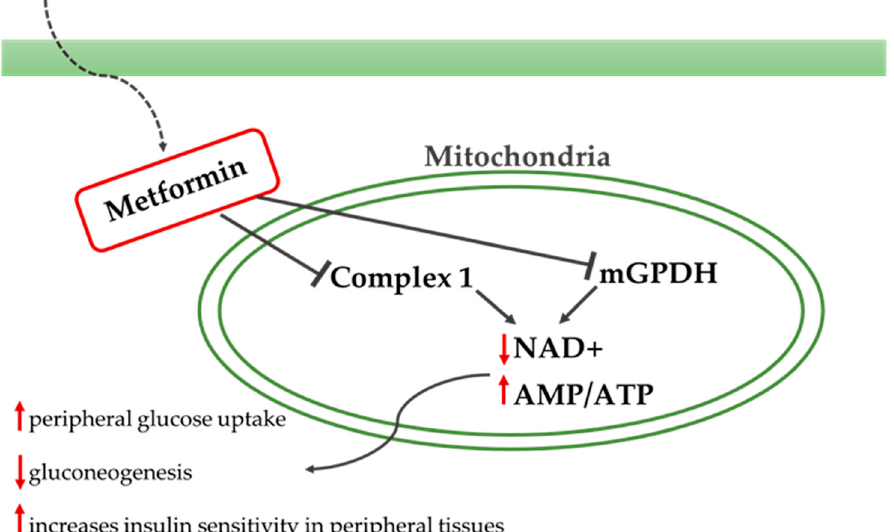
Figure 5. Metformin’s mechanism and signaling. Metformin acts in the liver, reducing hepatic glucose production by inhibiting gluconeogenesis and glycogenolysis. Metformin also acts in the muscles by increasing insulin sensitivity and improving peripheral glucose uptake and delays the absorption of glucose from the intestines. Metformin inhibits the mitochondrial respiratory-chain complex 1 and the mitochondrial glycerol phosphate dehydrogenase (mGPDH) leading to a reduction in NAD+ and ATP and to the above-described results.